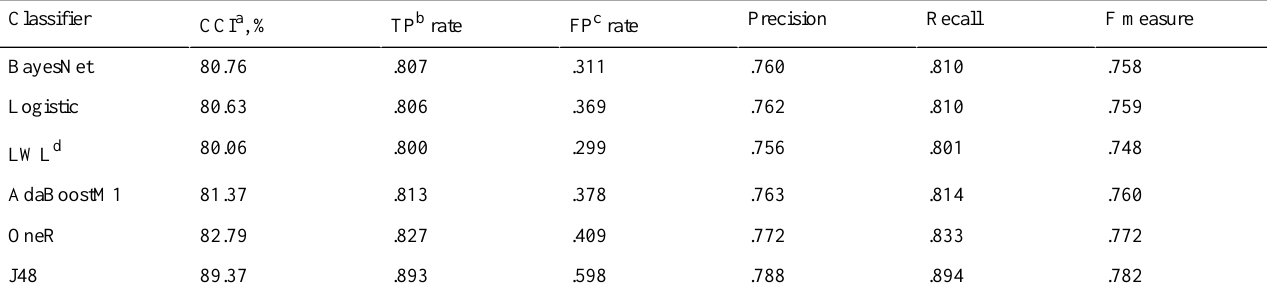
Table 11. Predicting the subjective norm based on the perceived ease of use, perceived usefulness, and perceived